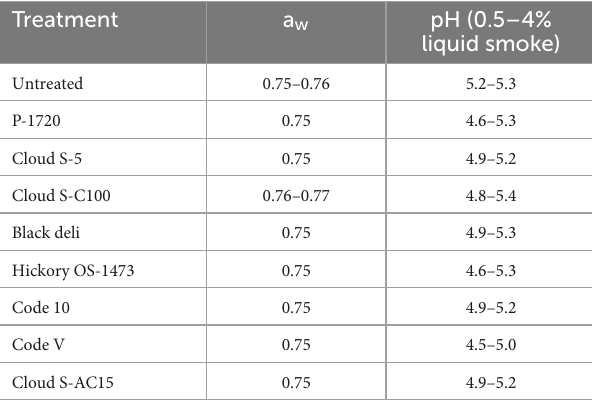
TABLE 3 Water activity (a w ) and pH of semi-moist pet food treatments without and with inclusion of liquid smoke (0.5–4%,